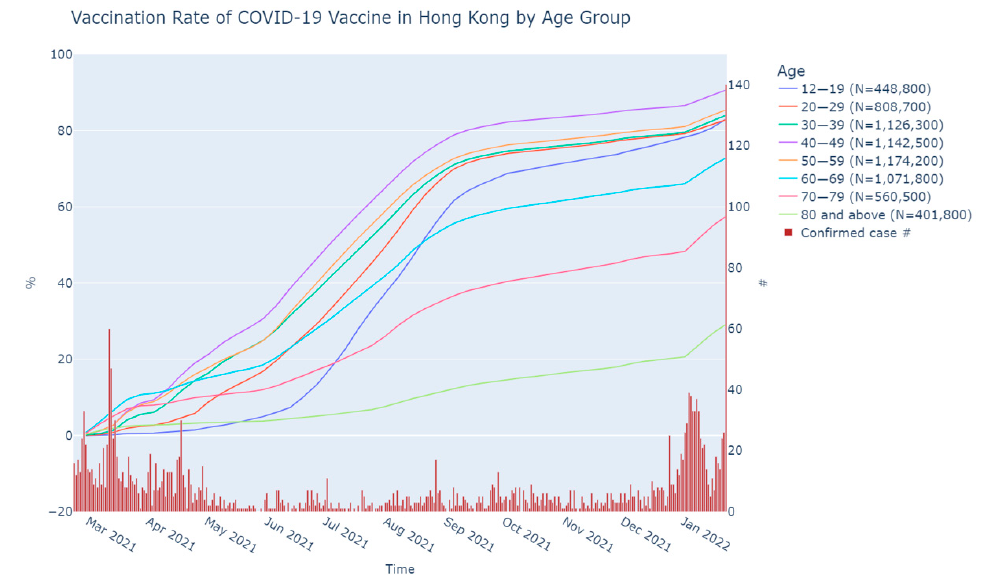
Figure 2. Vaccination rate of COVID-19 vaccination in Hong Kong by age group. 3.3. Absolute Change in Weekly Vaccination Rate by Age There were three peaks in the change of the VR, as shown in Figure 3. The first peak appeared from 21 March to 18 April, 2021, with a sudden dropped in the VR in early April that might be due to the temporary suspension of the BioNTech vaccine. Weekly incre- ments in the VR among age groups were up to 3.70%. The second peak was found from 13 June to 22 August, 2021, with a maximum of 5.50% (age 12–19), while the weekly in- crements in the VR of most age groups were above 3%. The last peak was observed in early January 2022. The weekly increments of VR raised from below 1% for all age groups to 1.19%–3.40%.